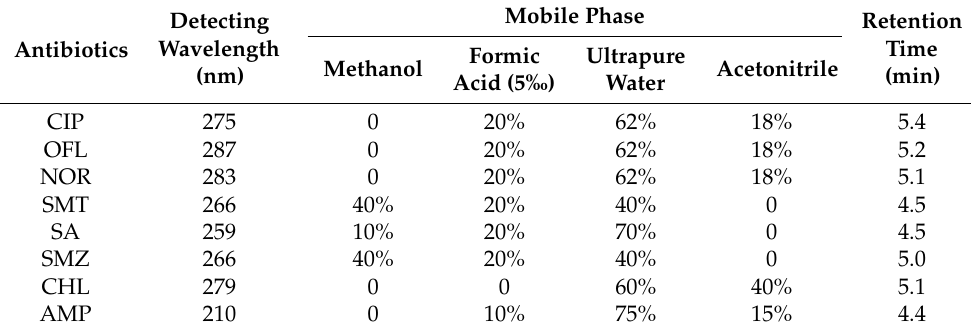
Table 4. HPLC detection